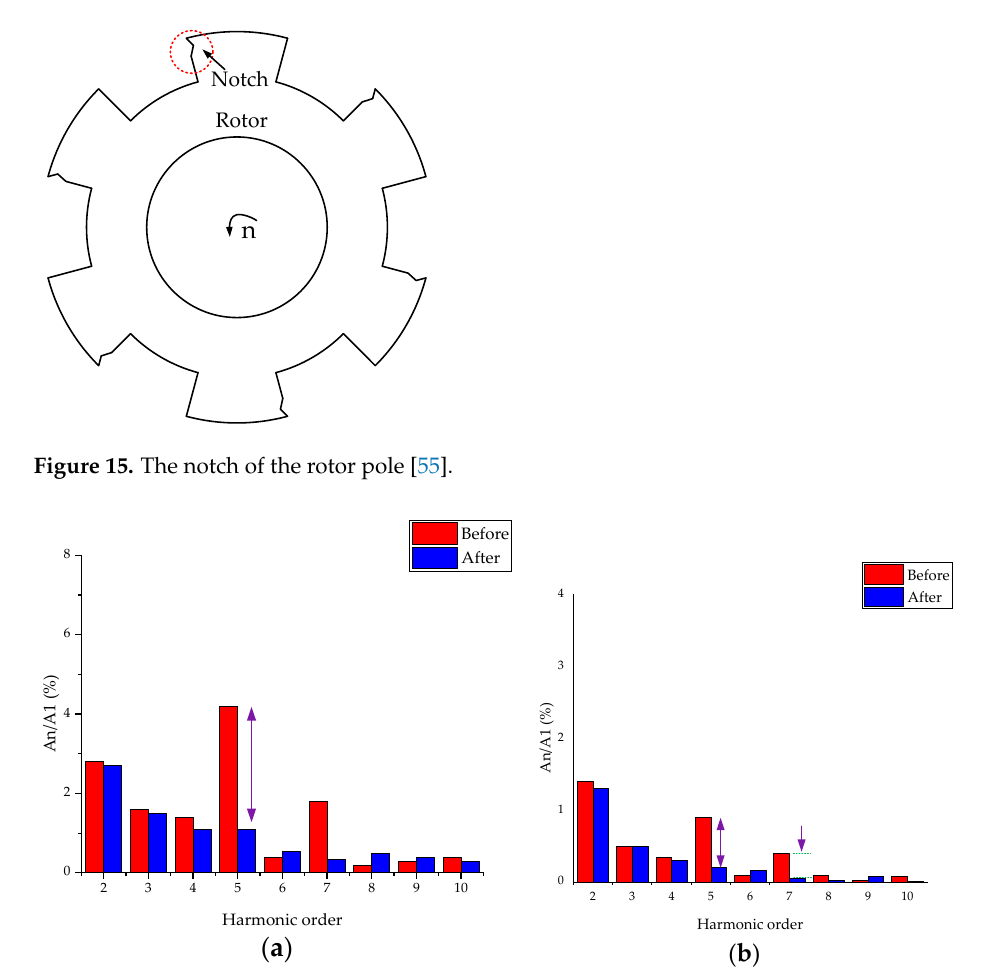
Figure 16. Harmonic analysis diagram [63]. ( a ) Permanent magnetic flux. ( b ) Back-EMF.